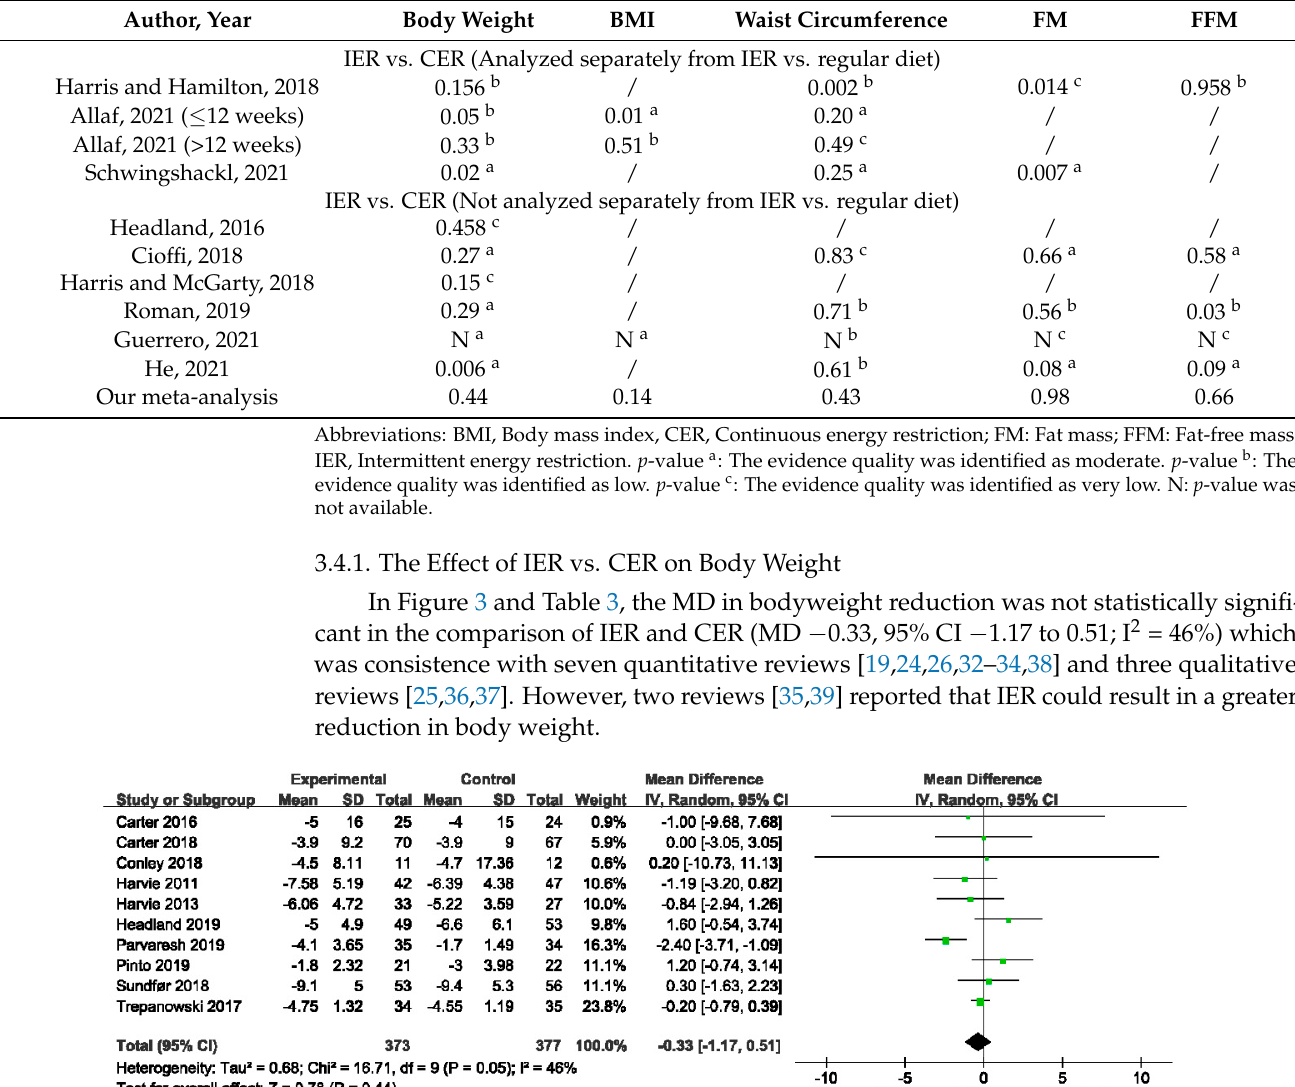
Table 3. Summarizes the p -values of included reviews with meta-analysis and our meta-analysis.